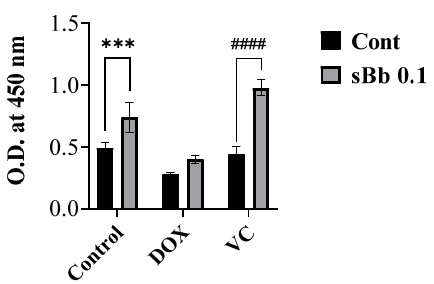
Figure 5. sBb increases the antigen-presenting capability of DCs. The DCs treated with DOX, VC, and/or sBb prior to co-culture and allogeneic spleen cells were co-cultured as described in the Materials and Methods. Cell Counting Kit-8 solution was used. The optical density was measured at 450 nm with a microplate reader. *** indicates p < 0.001 compared to control DCs, whereas #### indicates p < 0.0001 compared to the treated-DCs in the absence or presence of sBb.